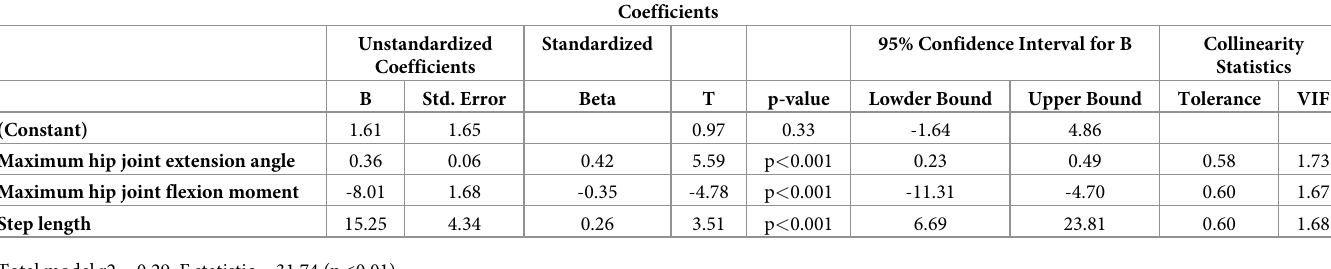
Table 3. Multiple linear regression analysis of data of patients with lumbar spinal stenosis (n = 222).